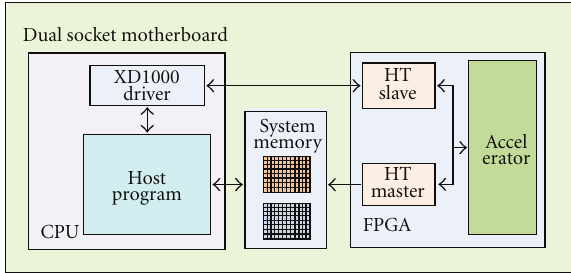
Figure 6: An XtremeData system with a XD1000 module.